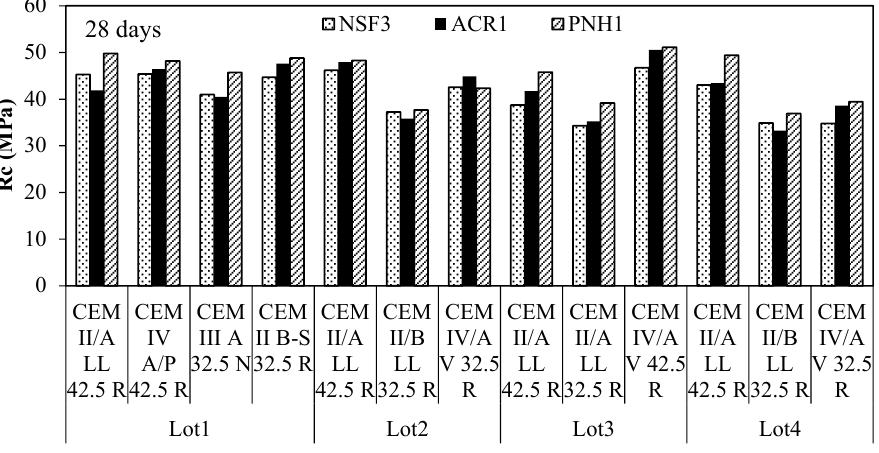
Figure 9. Compressive strength at 28 days.